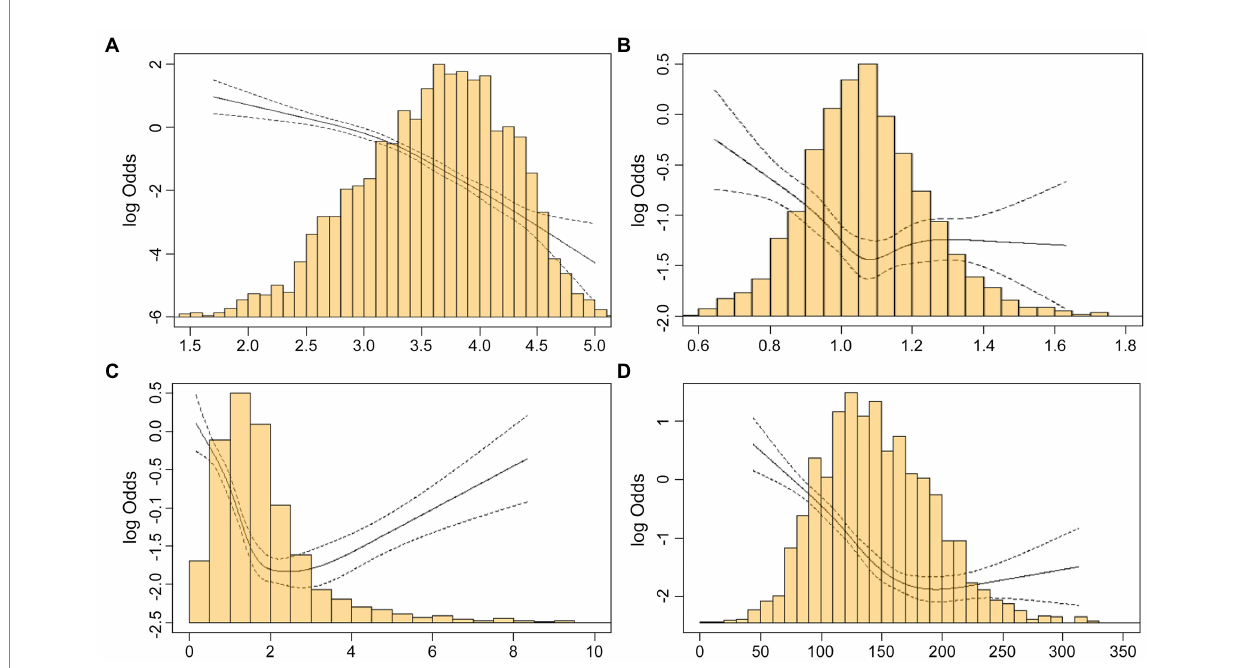
FIGURE 1 Restricted cubic spline plot of the relationships between components of nutrition indices and delirium. The solid line is the log odds, and the dashed lines are the upper and lower 95% confidence limits. (A) Restricted cubic spline plot for the association between albumin (g/dL) and delirium. (B) Restricted cubic spline for the association between bodyweight/ideal bodyweight and delirium. (C) Restricted cubic spline for the association between absolute lymphocyte count (x10 3 / μ L) and delirium. (D) Restricted cubic spline for the association between total cholesterol (ml/dL) and delirium.